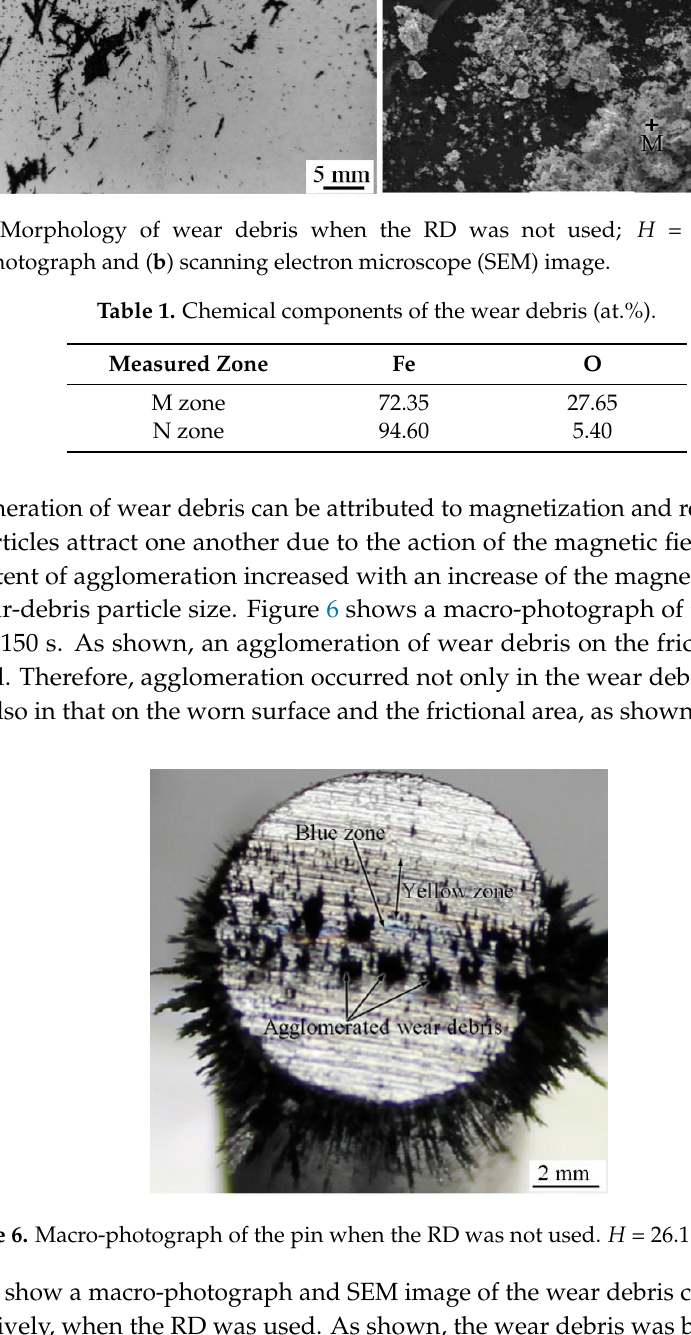
Figure 6 Macro-photograph of the pin when the RD was not used. H = 26.1 × 10 3 A/m. Figure 6. Macro-photograph of the pin when the RD was not used. H = 26.1 × 10 3